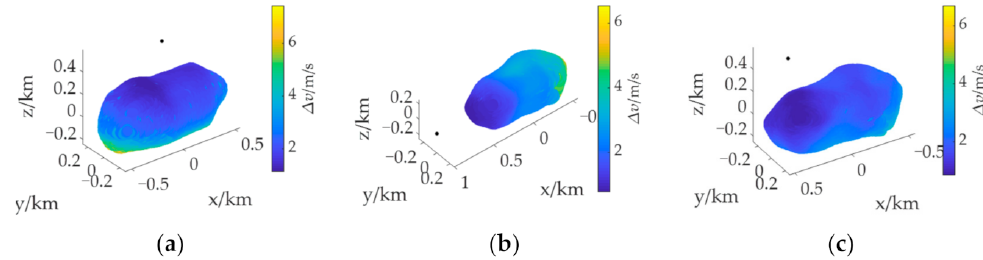
Figure 1. Velocity increment distributions at different initial positions. ( a ) Over the North Pole. ( b ) Over the Equator. ( c ) Over the mid-latitude